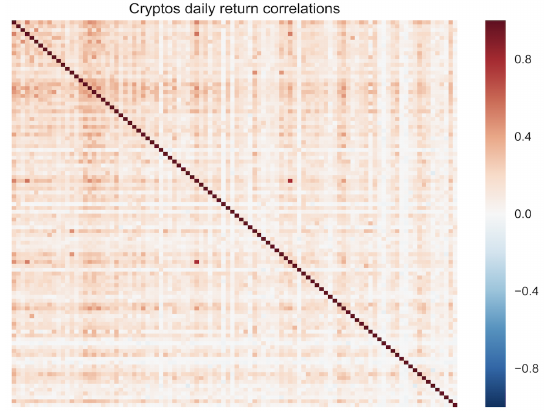
Table 5: Average statistics summary for price returns of the Top 100 Figure 3: Correlations of daily price returns between top 100 cryptocurrencies (Jan 2015 - Feb 2018) Table 6: Statistical summary for correlations of returns between top 100